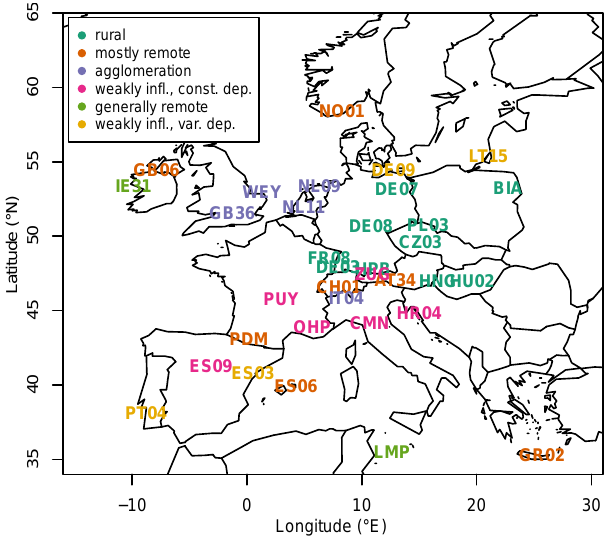
Fig. 4. Map of sites showing categorisation as obtained from clus- tering of parameters describing representativeness in the catchment